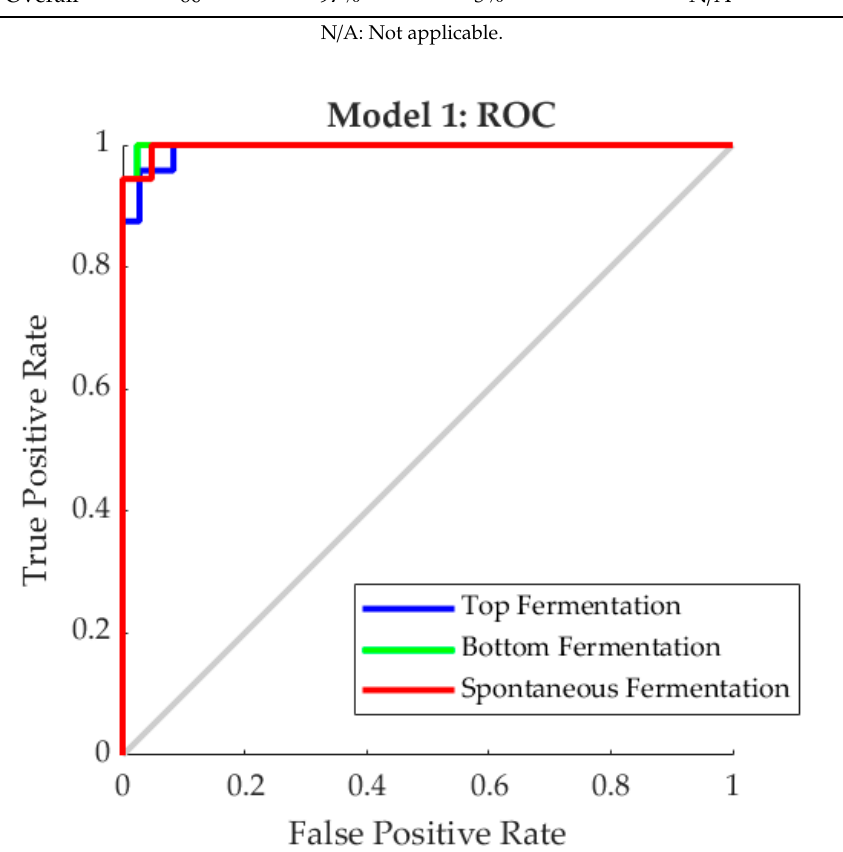
Figure 4. Receiver operating characteristics (ROC) curve depicting the true positive (y-axis) and false positive (x-axis) rates of Model 1 constructed to predict the type of fermentation of beers using the electronic nose outputs as inputs.